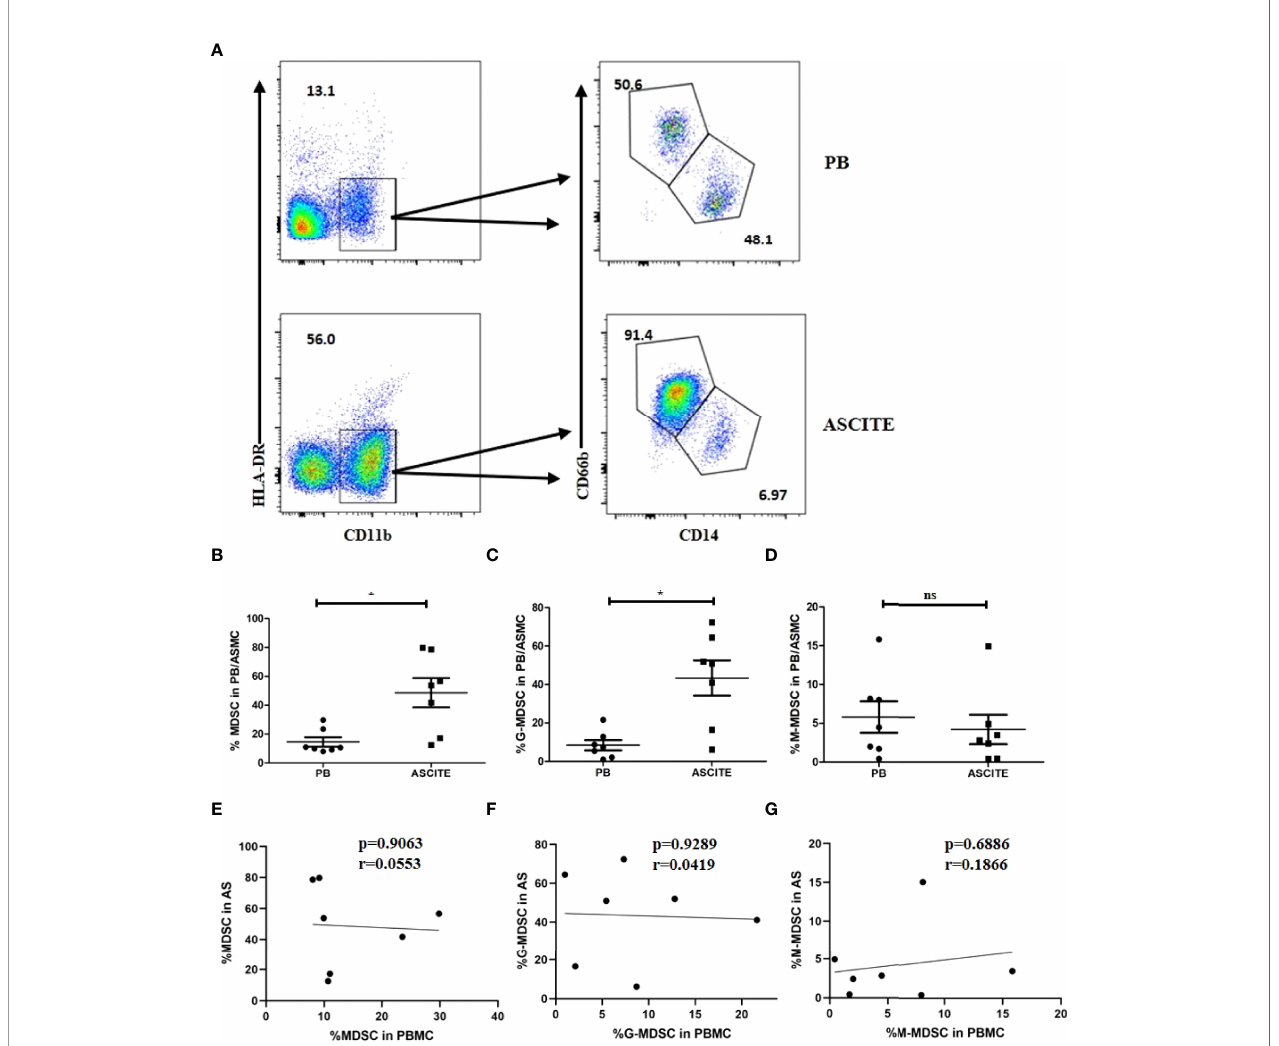
FIGURE 5 | The percentage of MDSCs in ASMCs in patients with SAP. (A) The fl ow cytometry analysis of MDSC and its subsets in ASMC and peripheral PBMC in patients with SAP. Percentages of MDSC (B) , G-MDSC (C) , and M-MDSC (D) in ASMC and PBMC in SAP patients. No signi fi cant difference was observed between the percentages of MDSC (E) , G-MDSC (F) , and M-MDSC (G) in PBMC and in ASMC. n = 7, * p < 0.05; ns, not signi fi cant. ASMC, ascitic fl uid mononuclear cell. PBMC, peripheral blood mononuclear